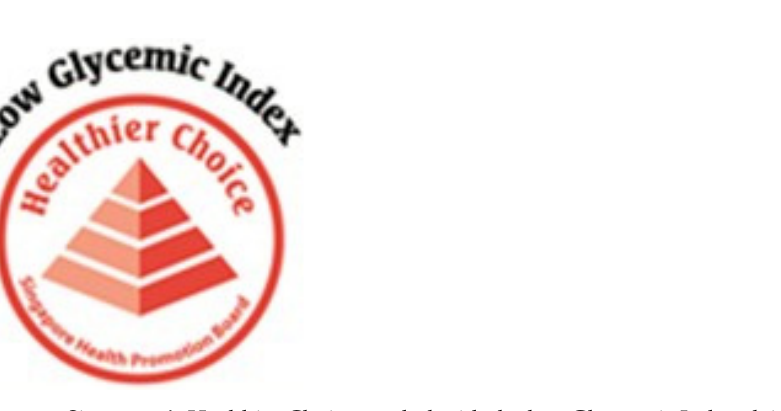
Figure 3. Singapore’s Healthier Choice symbol with the low Glycaemic Index claim.